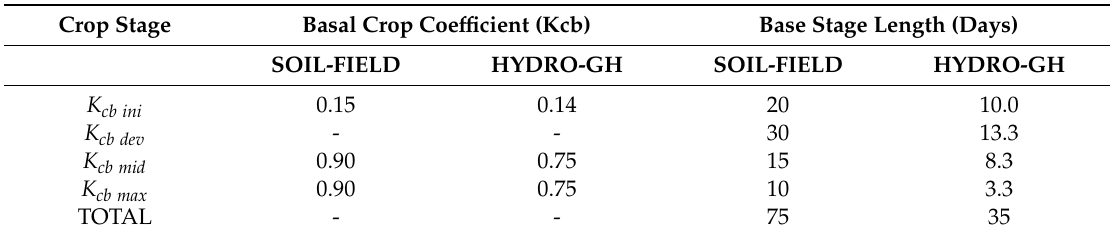
Table A3. Basal crop coe ffi cients and lengths for lettuce crop stage lettuce crops in soil-based (SOIL-FIELD) and hydroponic greenhouse (HYDRO-GH) systems, adapted from [16,26].